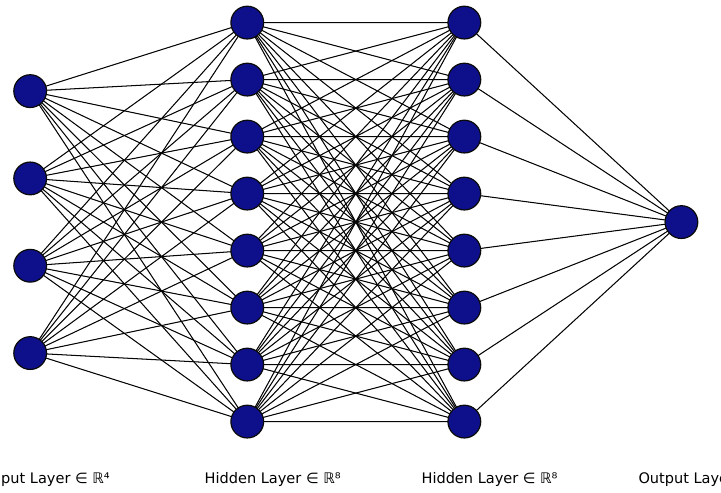
Figure 5. Artificial neural network